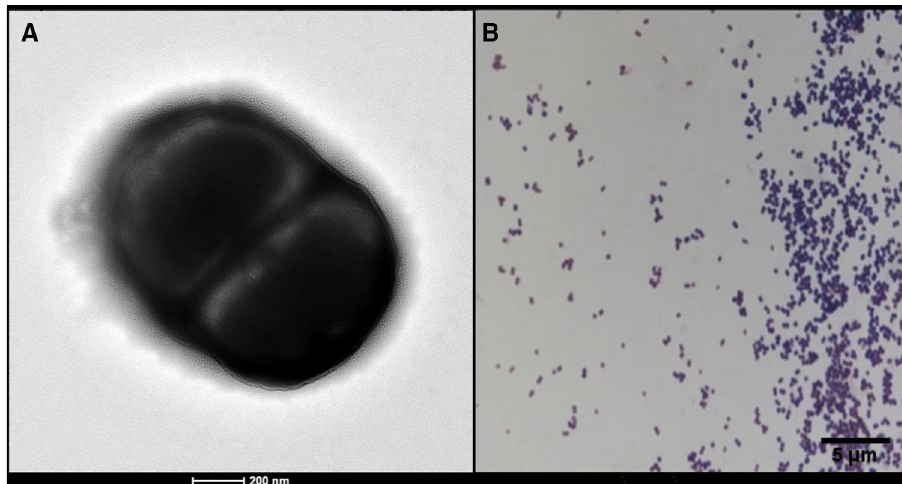
Figure 3. Morphology of Anaerococcus urinimassiliensis sp.nov. ( A ) Scanning electron microscopy of stained Anaerococcus urinimassiliensis sp. nov., Marseille-P2143 T . ( B ) Gram staining of Anaerococcus urinimassiliensis sp. nov., Marseille ‐ P2143 T .